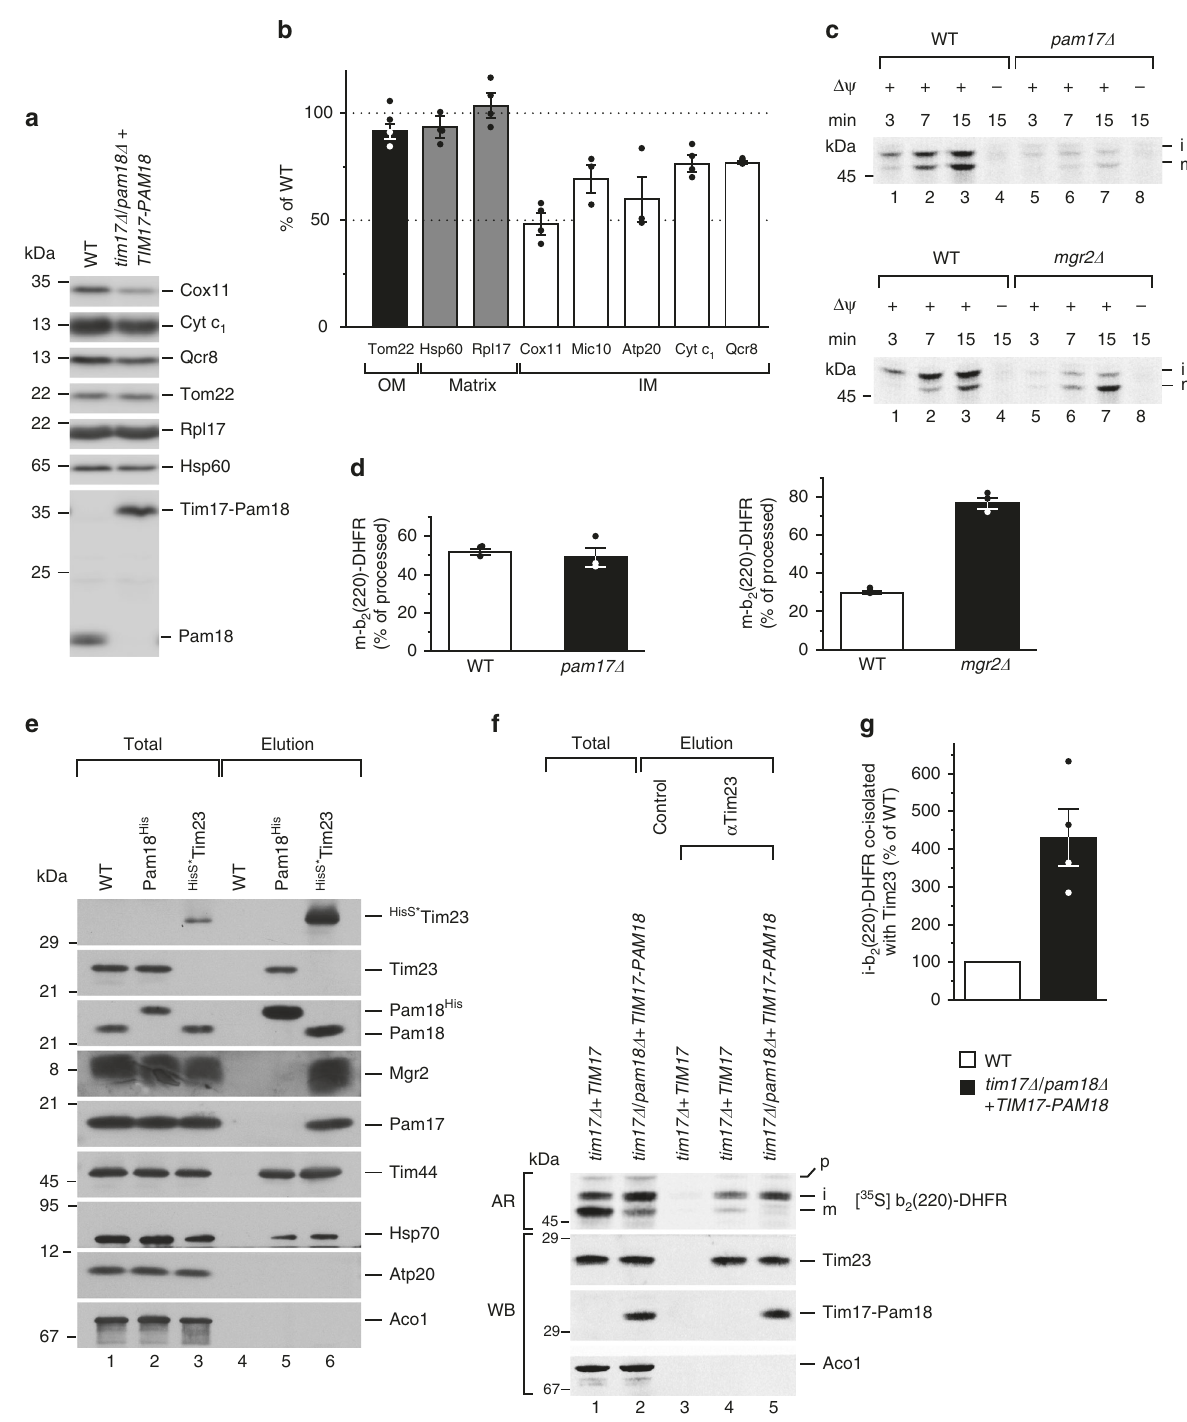
Fig. 4 Pam18 regulates the lateral gate. a Yeasts were shifted to glycerol medium and grown for 4 h (Mic10 and Atp20) or 6 h (all other tested proteins). Cell lysates were analyzed for levels of indicated outer membrane (OM), matrix or inner membrane (IM) proteins by western blot. b Quanti fi cation of blots from a . Amounts of proteins in percentage of WT control. Results are shown as mean ± SEM, n = 3 (Mic10 and Atp20) n = 4 for all others. c , d Import of [ 35 S]-labeled b 2 (220)-DHFR in mgr2 Δ and pam17 Δ and corresponding wild-type as described in Fig. 2. e WT mitochondria or mitochondria containing Pam18 His or HisS* Tim23 were solubilized in digitonin buffer and subjected to Ni-NTA af fi nity chromatography. Samples were analyzed by SDS-PAGE and western blotting. HisS*, His-SUMOstar. f After import of [ 35 S]-labeled b 2 (220)-DHFR without proteinase K treatment, mitochondria were solubilized in digitonin buffer and subjected to anti-Tim23 immunoisolation. Samples were analyzed by SDS-PAGE, western blotting, and digital autoradiography. AR, autoradiography; WB, western blot. g Quanti fi cation of co-isolated i-b 2 (220)-DHFR normalized to isolated Tim23. Results are shown as mean ± SEM, n = 4; p, precursor; I, intermediate;m, mature